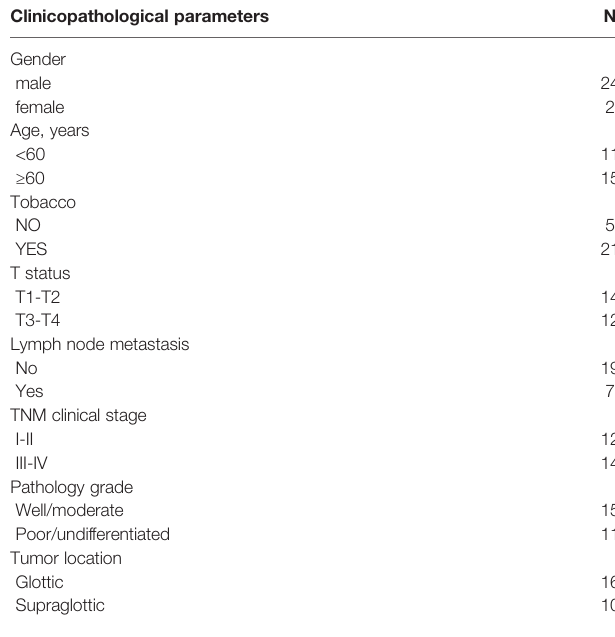
TABLE 5 | Clinicopathological parameters of 26 laryngeal cancer patients in our